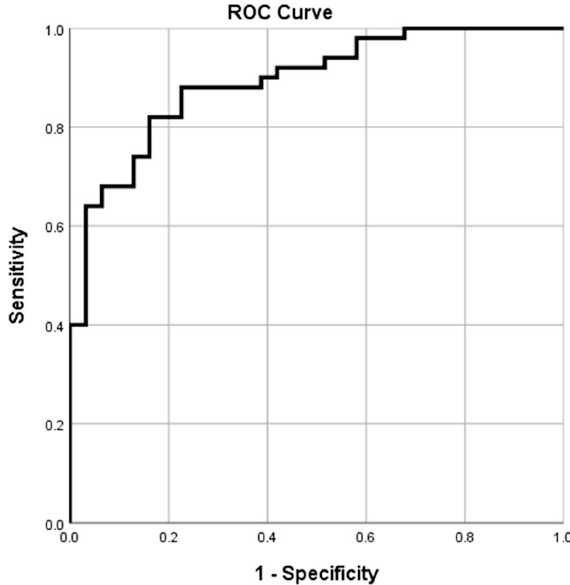
Table 5. Cutoff values of hand grip strength for predicting optimal Accuhaler and Turbuhaler PIFR. Variable